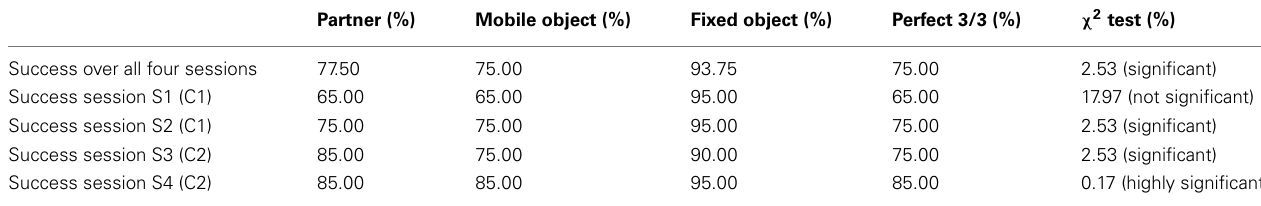
Table 2 | Frequency of correct responses – experiment